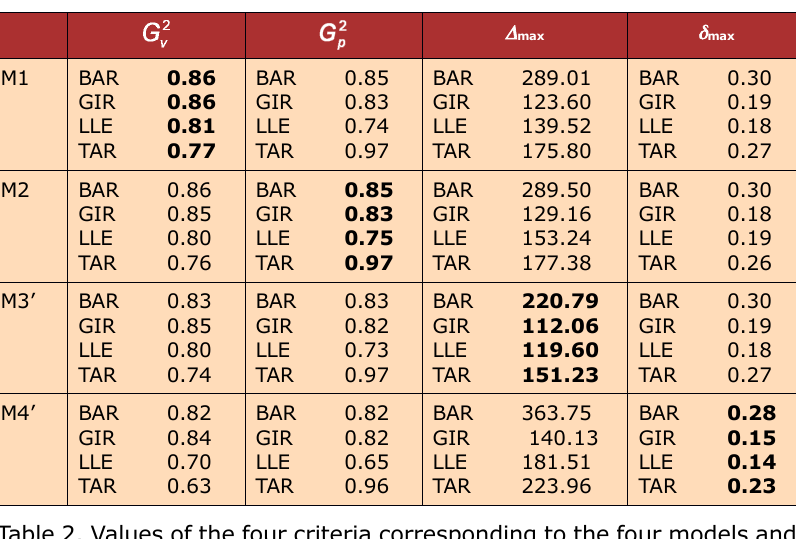
Table 2. Values of the four criteria corresponding to the four models and the four constituencies: Barcelona (BAR), Girona (GIR), Lleida (LLE) and Tarragona (TAR). The best values of the criteria, for each constituency, are highlighted in bold. Of course, they are, for , ,  max and  max those obtained, respectively, with models M1, M2, M3’ and